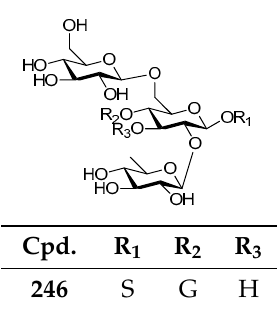
Figure 51. Structure of compound 245 .